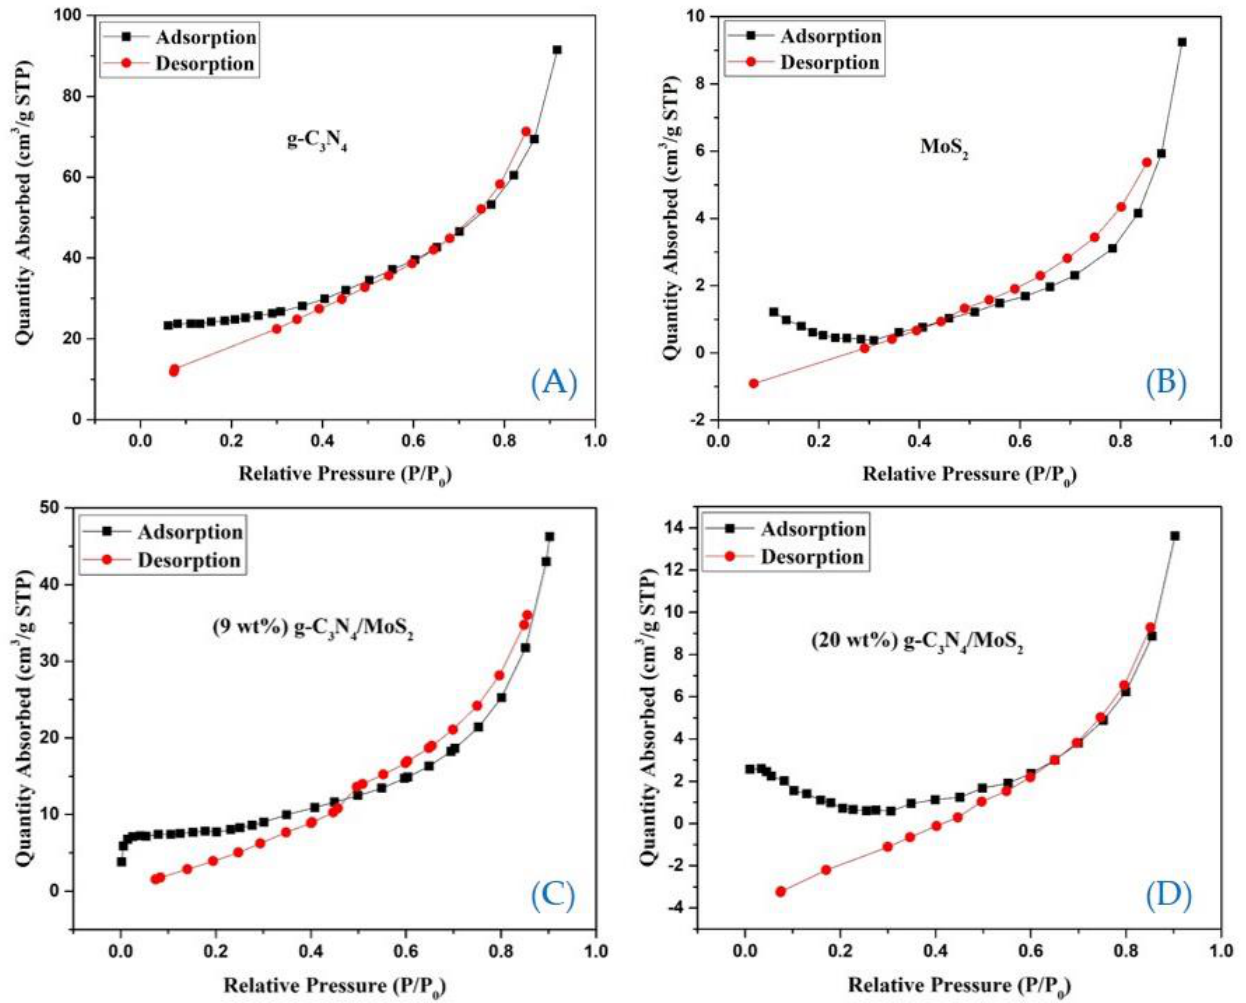
Figure 11. Nitrogen adsorption-desorption isotherm curves of ( A ) g-C 3 N 4 , ( B ) MoS 2 , ( C ) g-C 3 N 4 /MoS 2 (9 wt%) and ( D ) g-C 3 N 4 /MoS 2 (20 wt%).